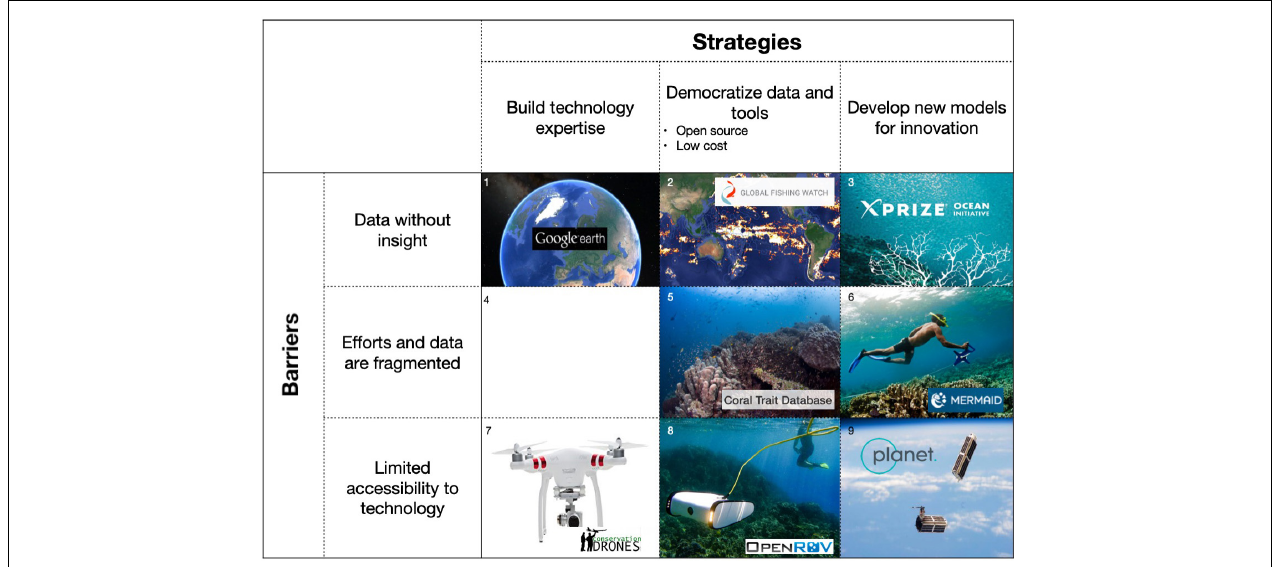
FIGURE 1 | Matrix of illustrative coral reef science and conservation technology solutions that match innovative strategies to known barriers. From top left to bottom, (1) Google Earth Outreach offers free training and access to their remote sensing platforms to assist with geospatial data analysis; (2) Global Fishing Watch allows managers and scientists to freely monitor illegal fishing activity worldwide; (3) the Wendy Schmidt Ocean Health XPRIZE incentivizes ocean technology solutions from teams of engineers, scientists and innovators in a global competition; (4) represents open space where technology tools should strive to meet this gap; (5) the Coral Trait Database is a growing compilation of freely available coral species data to centralize and standardize previously fragmented scientific information; (6) MERMAID is an open source web application developed by coral reef field biologists and web designers to manage underwater transect data; (7) organizations like Conservation Drones and She Flies provide training in using unmanned aerial vehicles (drones) for ocean monitoring and biodiversity conservation; (8) Open ROV seeks to make telerobotic submarines available at low-cost for affordable underwater exploration; similarly, GoPro cameras and the Liquid Robotics Wave Glider (not shown) are examples of affordable cameras and ocean robots, respectively, to allow scientists to access ocean health information; (9) Planet Labs is a private Earth imaging company that manufactures nano satellites for commercial uses but provides free high resolution imaging data to scientists. All photographs provided by named organizations, with the exceptions of (5) Emily Darling; (6) James Morgan; (7)